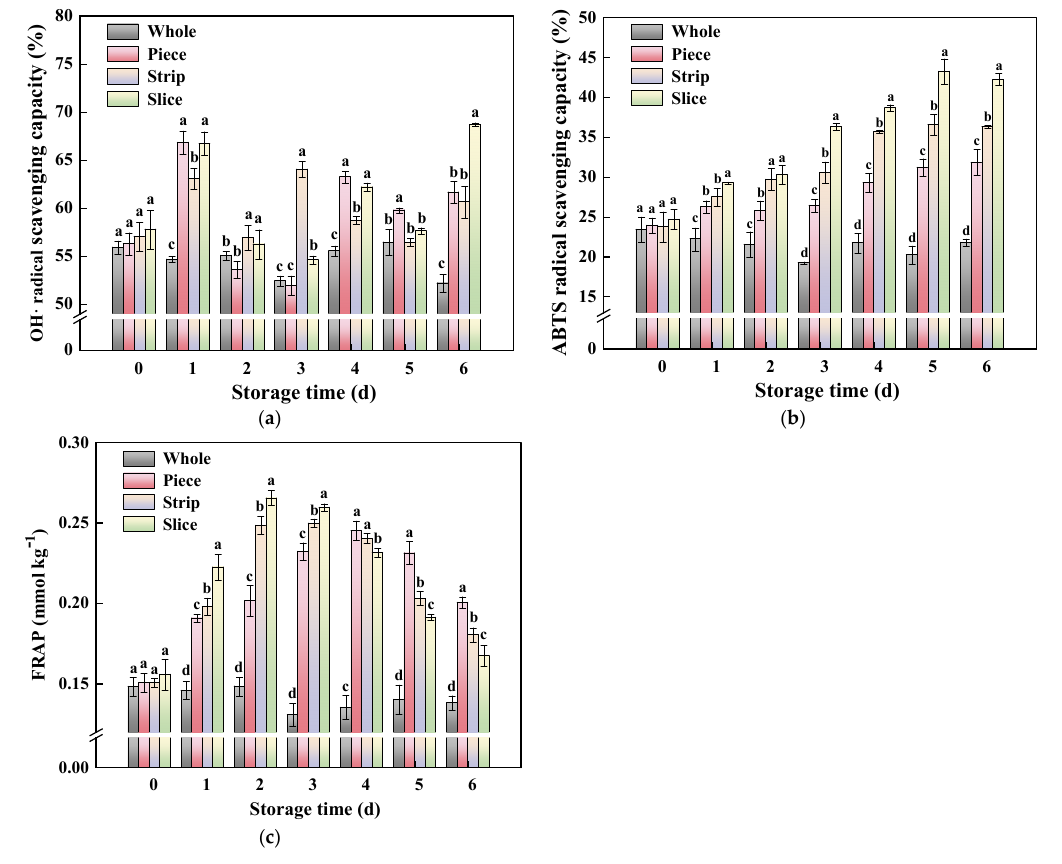
Figure 8. Effect of wounding intensities on OH • ( a ), ABTS ( b ) radical scavenging capacity and FRAP ( c ) of fresh-cut pumpkin during storage at 4 ◦ C for 6 days. Vertical bars represent the standard deviation of the mean (n = 3). Different letters indicate significant differences between the groups ( p < 0.05).